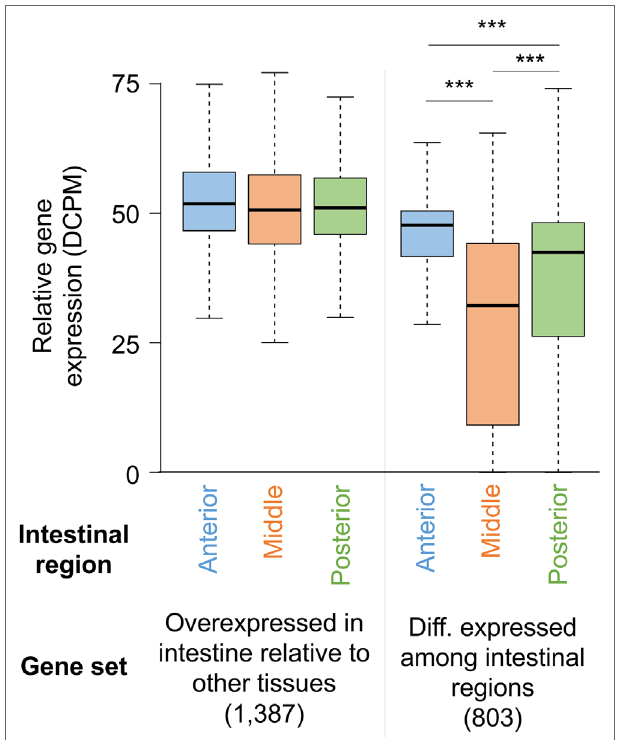
FIGURE 4 | Distribution of gene expression levels for A. suum genes in the anterior, middle, and posterior intestine regions among all intestine- overexpressed genes and genes differentially expressed between the regions. *** P < 10 −5